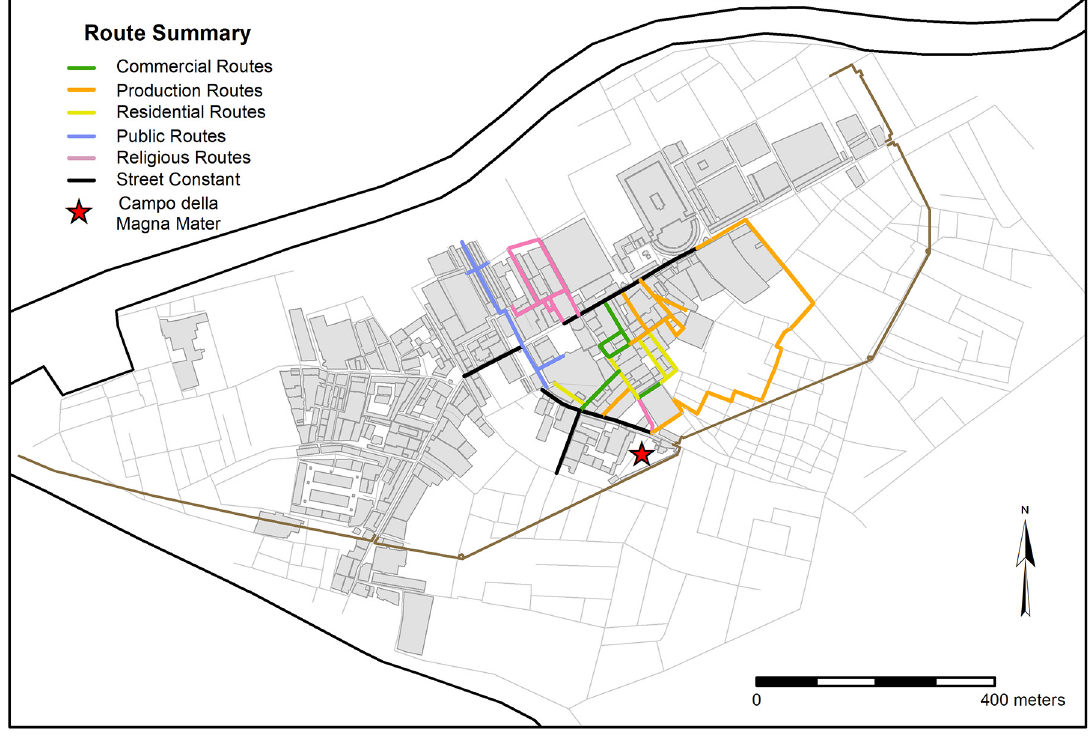
Figure 13. Map showing a summary of possible movement routes weighted by each classification category. Streets displayed in black represent pathways consistently used by each weighted classification